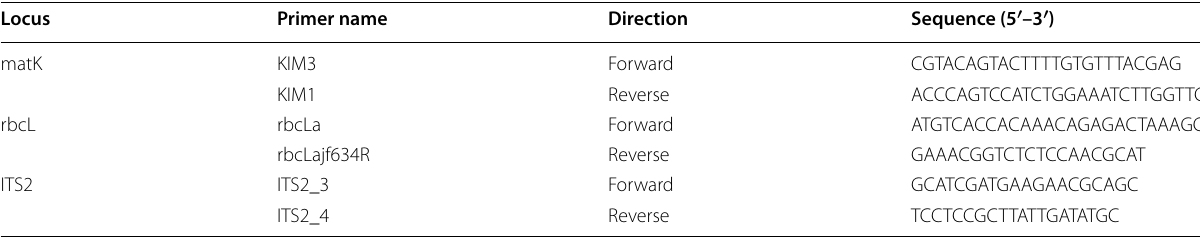
Table 2 Primers used for PCR amplification